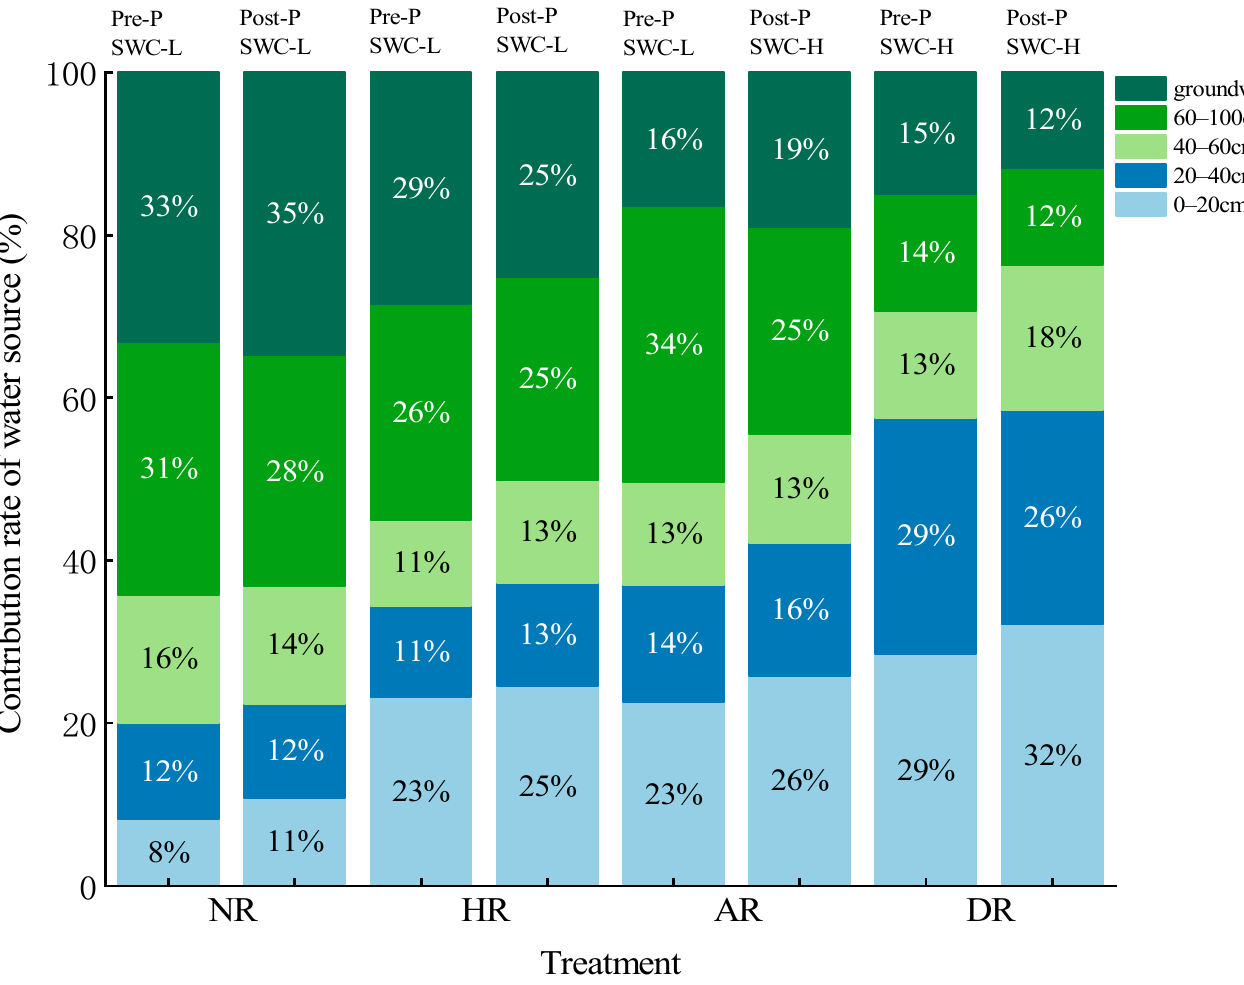
Figure 13. The contribution rate of different water sources to the water use of P. orientalis before and after the rainfall event on 4